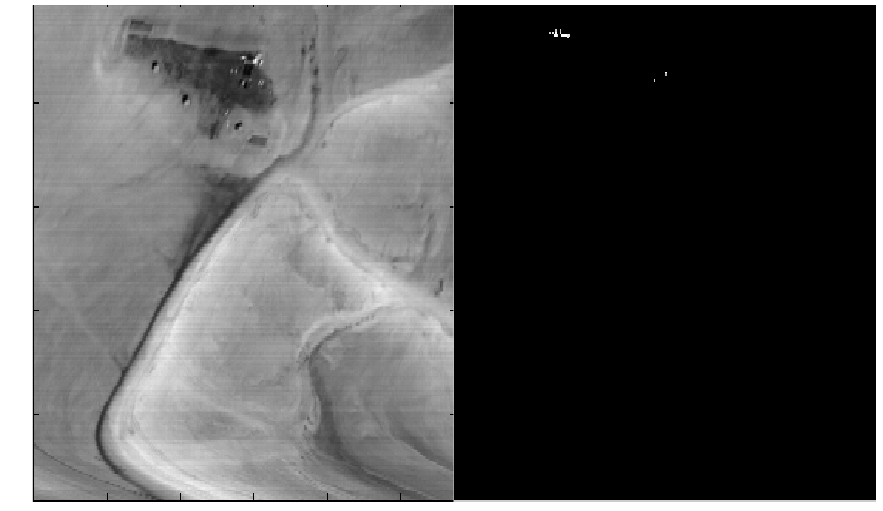
Figure 16. Left: The scene from Figure 4. Right: Points that contain a target in above pixel when t = 1 .